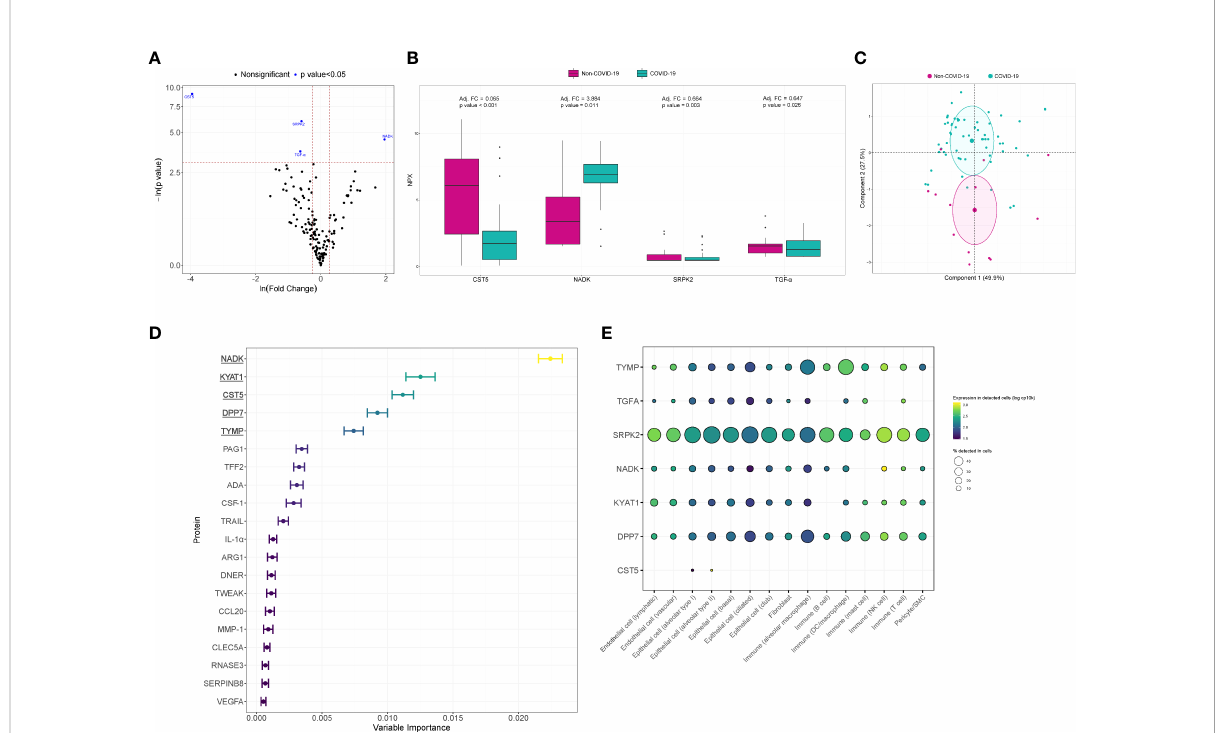
FIGURE 2 Proteomic biopro fi les in bronchial aspirates from COVID-19 and non-COVID-19 ARDS patients. (A) Volcano plot showing the p value versus the fold change. Each point represents a detected protein. Blue dots represent the detected proteins that showed signi fi cant differences considering a p value<0.05. The association was adjusted by a propensity score (PS) compound by age, sex, obesity, chronic pulmonary disease, use of antibiotics, use of tocilizumab and use of corticoids. (B) Boxplot including bronchial aspirate proteins that showed differences between study groups. The adjusted fold change is displayed, and the signi fi cance level for each comparison is described by the p value. (C) Principal component analysis. Each point represents a patient. (D) Variable importance plot displaying the most relevant proteins according to their contribution to the random forest model. (E) Cell enrichment analysis based on single-cell RNA-seq data from Genotype-Tissue Expression (GTex). Each row represents a protein, and each column represents a cell type. The color of the point shows the expression levels in detected cells, and the size of the point indicates the percentage of cells in which the expression was